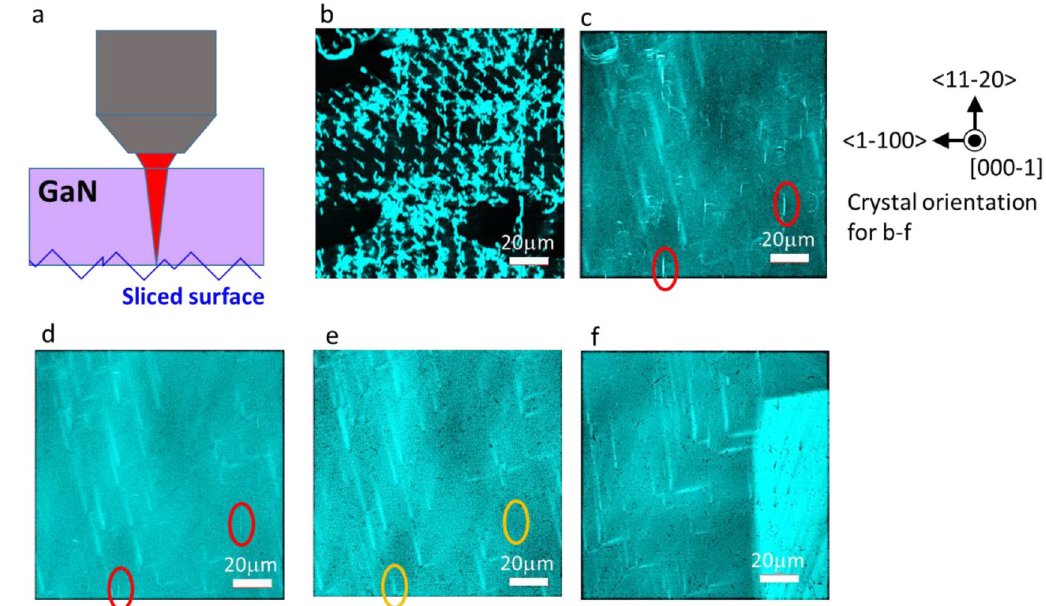
Figure 5. Evaluation of damage caused by laser slicing with multiphoton microscope. ( a ) Schematic cross- sectional view of multiphoton microscopy observation at the slice plane from the back side of the sample. ( b ) PL (365 nm) image observed at sliced surface. The damage generated by laser scanning is observed as a bright contrast. ( c ) PL (365 nm) image observed at a depth of 37 µm from the sliced surface ( b ). Strong linear bright contrasts show damage. Pale bright contrasts do not show damaged areas, but the area where the original properties of the substrate are slightly different, regardless of the extent of laser damage. Typical laser-damaged areas are encircled in red. ( d ) PL (365 nm) image observed at a depth of 42 µm from the sliced surface ( b ). The deep-laser-damaged area encircled in red is barely visible. ( e ) PL (365 nm) image observed at a depth of 79 µm from the sliced surface ( b ). Almost no damage contrast is visible even at the position of the deep-laser-damaged area (orange circles). Black dots are dislocation defects that originally exist in the GaN substrate. In ( b – d ) dislocations are difficult to recognize by multiphoton microscopy because of the depth of observation. ( f ) PL (365 nm) image of the GaN substrate that contain only substrate-derived crystal defects for comparison.